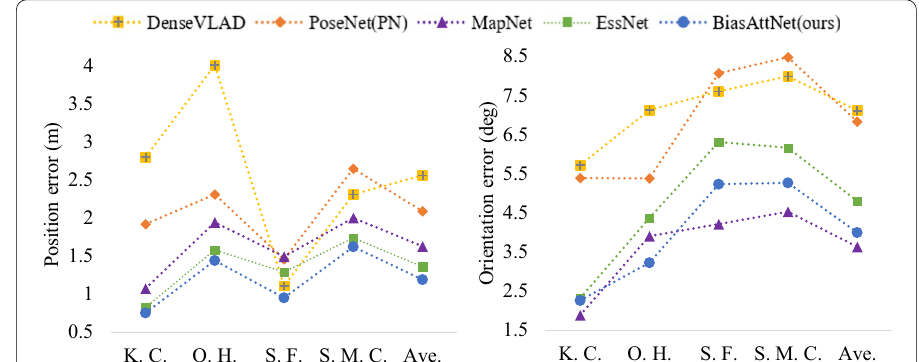
Fig. 8 Position and orientation errors of the various methods on the Cambridge Landmarks dataset. (K.C. stands for King’s College, O.H. for Old Hospital, S.F. for Shop Facade, S.M.C. for St Mary’s Church, and Ave. for Average.)